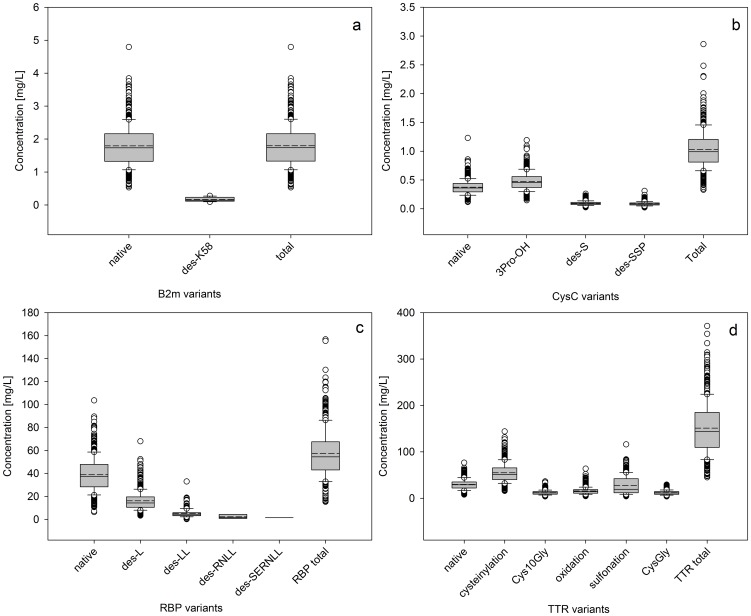
Individual concentrations of (a) b2m, (b) CysC, (c) RBP, and (d) TTR, and their variants among the 500 individuals.Box - 25-75th percentile; Solid line – median concentration; Short dash line – mean concentration; Error bars – 10th and 90th percentile; Symbols – outlying points.